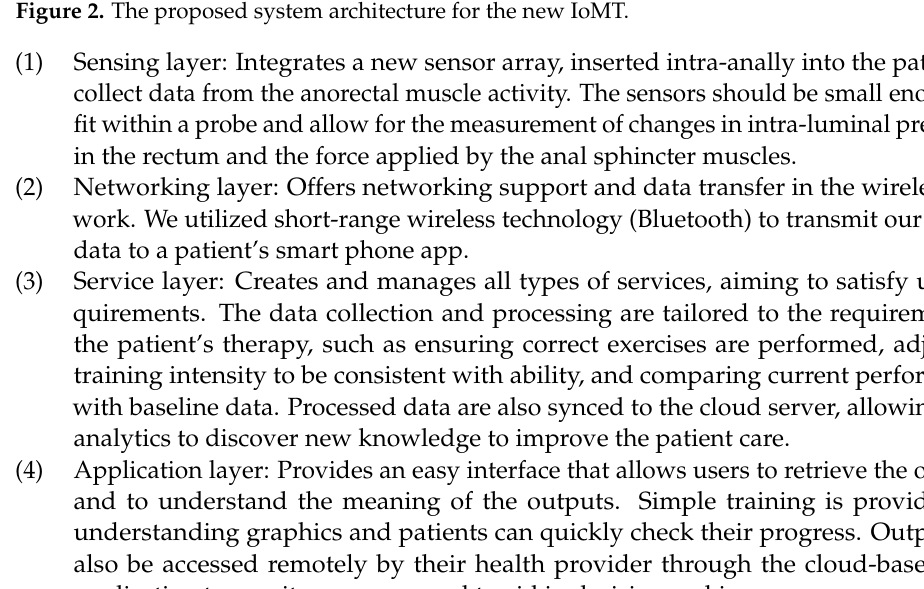
Figure 2. The proposed system architecture for the new IoMT.